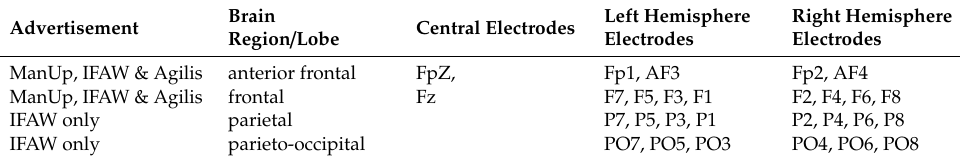
Table 5. EEG electrodes showing increase in theta and decrease in alpha